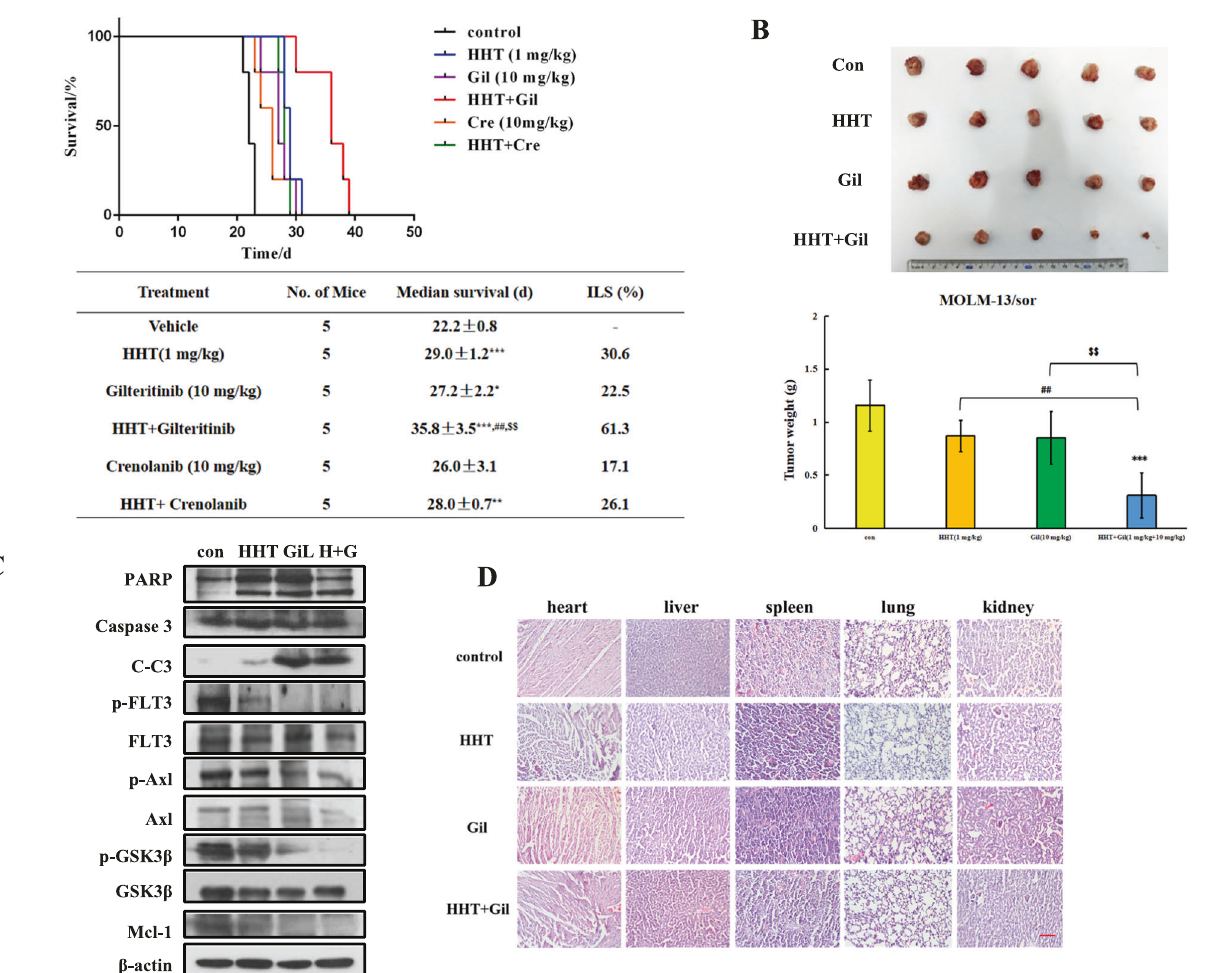
Fig. 6 The combined effects of HHT with gilteritinib in MOLM-13/sor xenografts. A Survival curves of MOLM-13/sor xenografted mice inoculated through the tail vein and treated with HHT, gilteritinib, crenolanib, or their combination for 12 days. B Tumor image and tumor weights of MOLM-13/sor cells inoculated subcutaneously into NOD-SCID mice treated with HHT, gilteritinib, or the combination for 6 days. *** P < 0.001 compared with the control group. ## P < 0.01 compared with the HHT group. $$ P < 0.01 compared with the gilteritinib group. C Protein analysis in tumor tissue. D H&E staining of heart, liver, spleen, lung, and kidney of mice. The scale bar is 100 μ